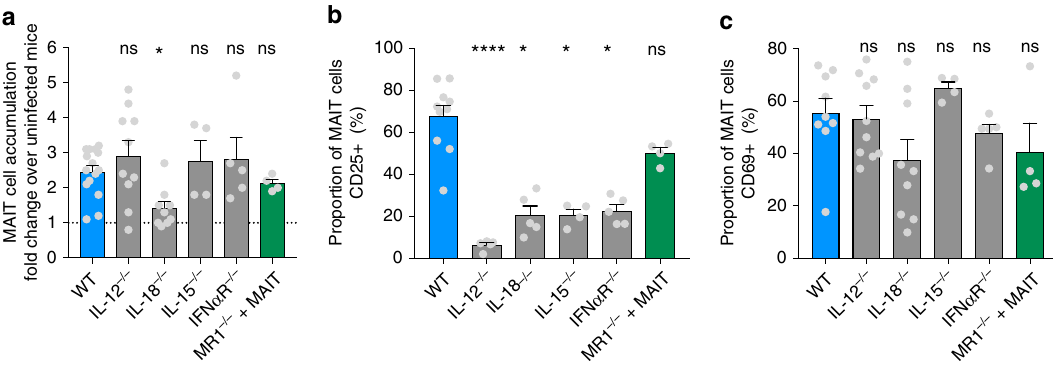
Fig. 2 MAIT cell accumulation and activation are modulated through cytokines, independent of MR1. Accumulation and activation of MAIT cells in wild type (WT) C57BL/6 mice or mice de fi cient in IL-12, IL18, IL-15, IFN α R or MR1 5 days after challenge with 100 plaque-forming units (PFU) PR8 virus. Mice de fi cient in MR1 had received adoptive transfer of 1.8 × 10 5 pulmonary MAIT cells 2 weeks earlier, from WT mice previously infected with 10 6 CFU S. Typhimurium BRD509 for 7 days to expand the MAIT cell population. a Fold accumulation of pulmonary MAIT cells relative to uninfected controls. b , c Proportion of pulmonary MAIT cells expressing CD25 ( b ), and c CD69 expressed as a percentage. Graphs show combined data (mean ± SEM) from one (IL-15 − / − , IFN α R − / − , MR1 − / − ) or two (IL-12 − / − , IL-18 − / − ) independent experiments with similar results. Groups compared with WT by Kruskal – Wallis with post hoc Dunn ’ s tests; * P < 0.05, ** P < 0.01, **** P <